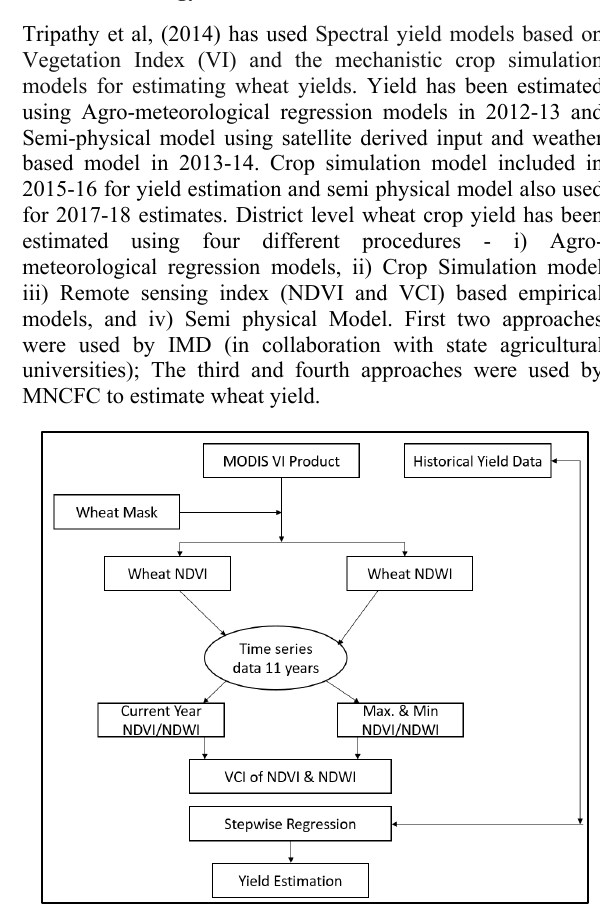
Figure 5. Flow diagram for calculation of yield using Vegetation Condition Index (VCI) (Dubey et al.,